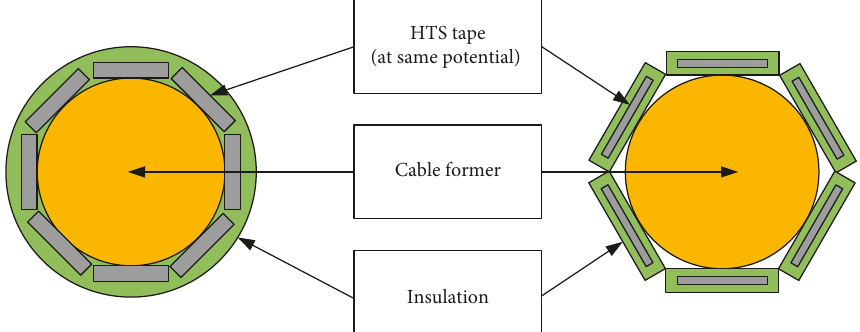
Figure 1: Lapped tape insulated HTS cable (left) and individually insulated HTS tape cable configuration (right) (note: not to scale and a typical HTS cable would consist of more HTS